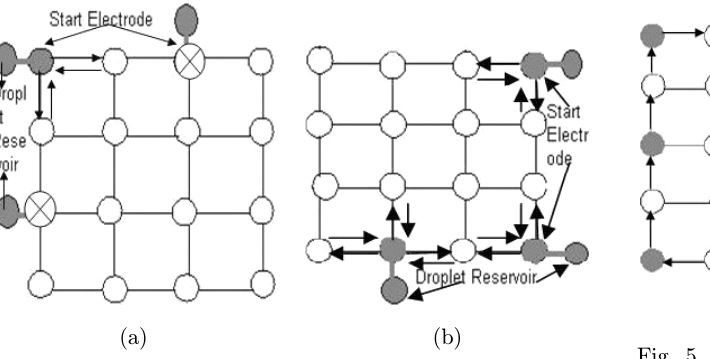
Fig. 3. Selection of start electrode.